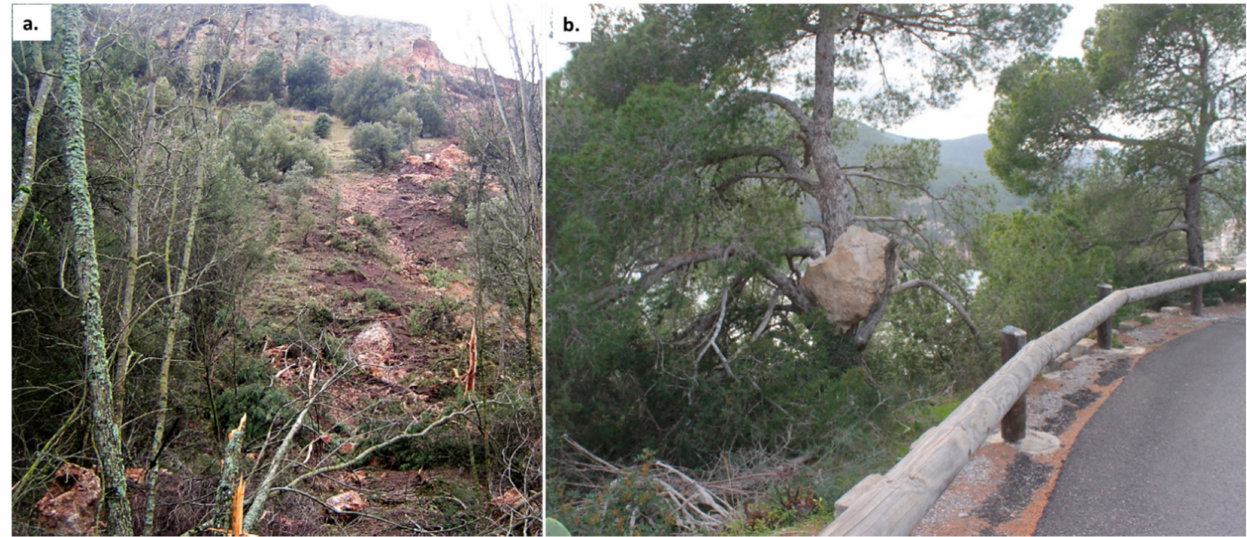
Figure 5. Examples of the protective effect of forests against rockfalls; ( a ) rockfall in Covarrubias (Burgos), where trees reduced the velocity and the rebound heights of the falling rocks, and ( b ) rockfall boulder “hanging” from pine in Cala Sant Vincent